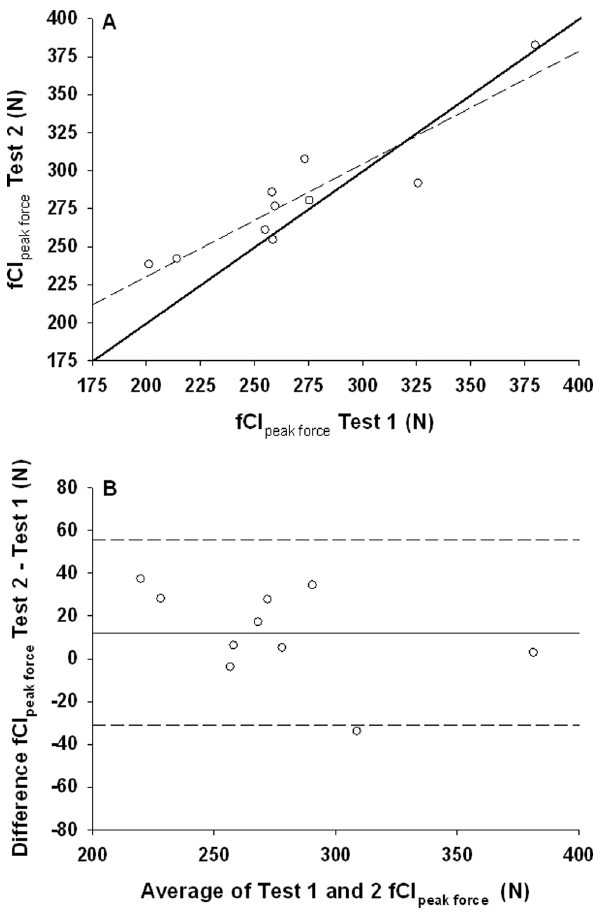
Figure 4. Test-retest correlations of fCF peak force . Panel A: fCF as peak force. Line of identity is shown as a solid line and the fitted regression as a dashed line. Panel B: Bland-Altman plot of fCF peak force . Mean difference between test 1 and test 2 (bias; solid line) 6 43.2 N 95% limits of agreement (dashed lines).